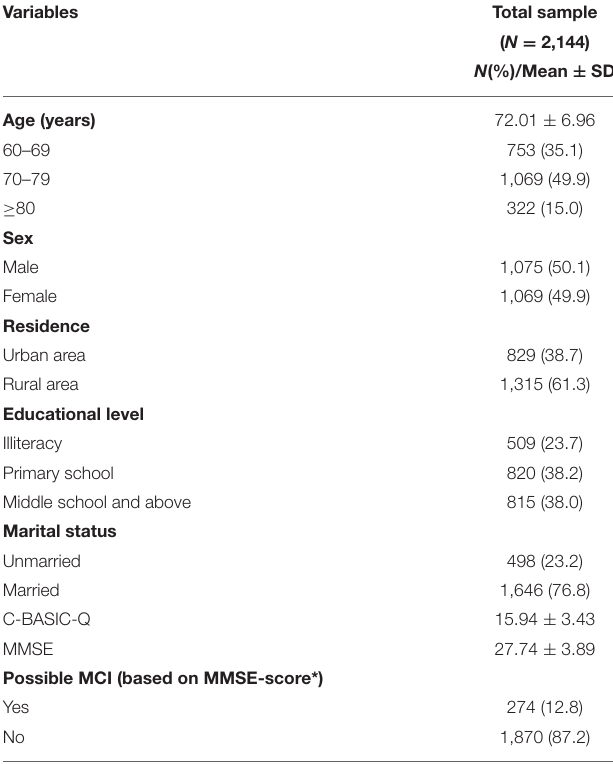
TABLE 1 | Descriptive statistics for the